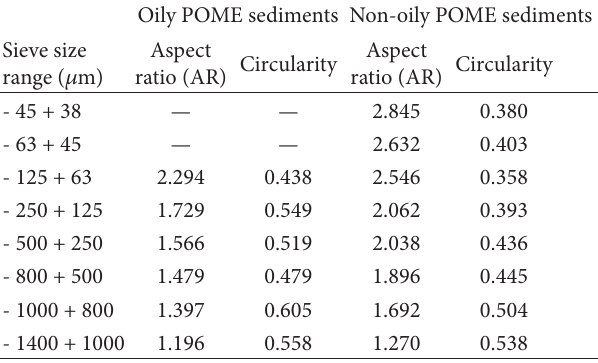
T 5: Shape factors for oily and non-oily POME